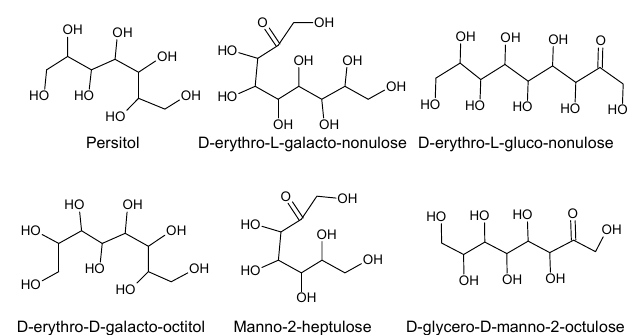
Figure 4. Sugars and sugar alcohol isolated from avocado.